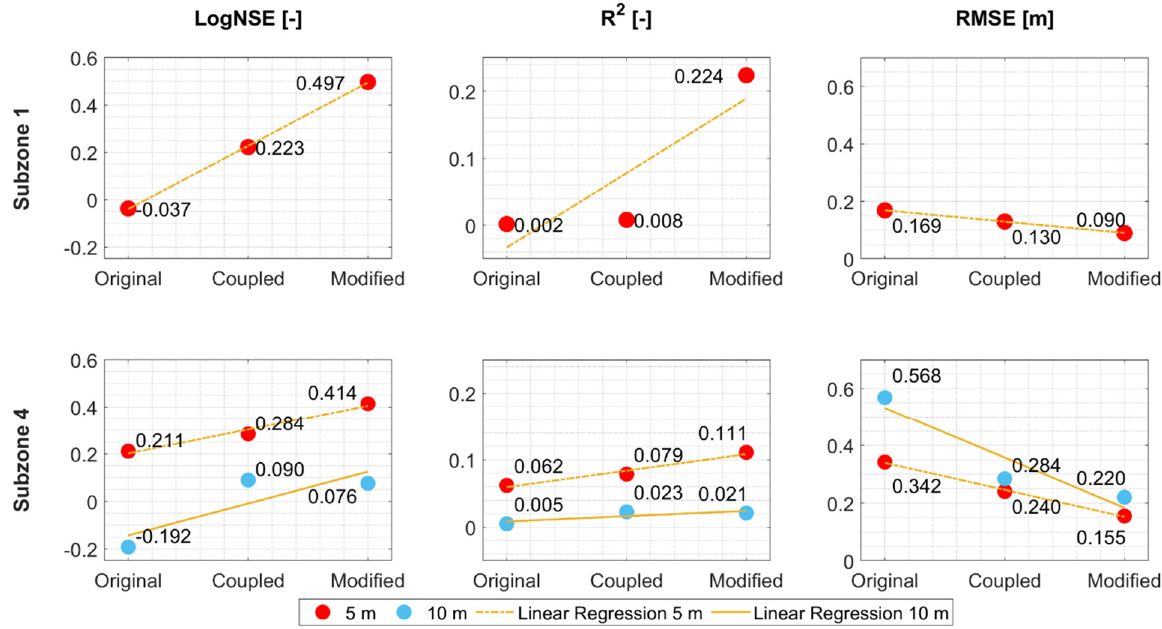
Figure 9. GOFs for the original (2 m), first coupling and the additional manual adaption (modified).